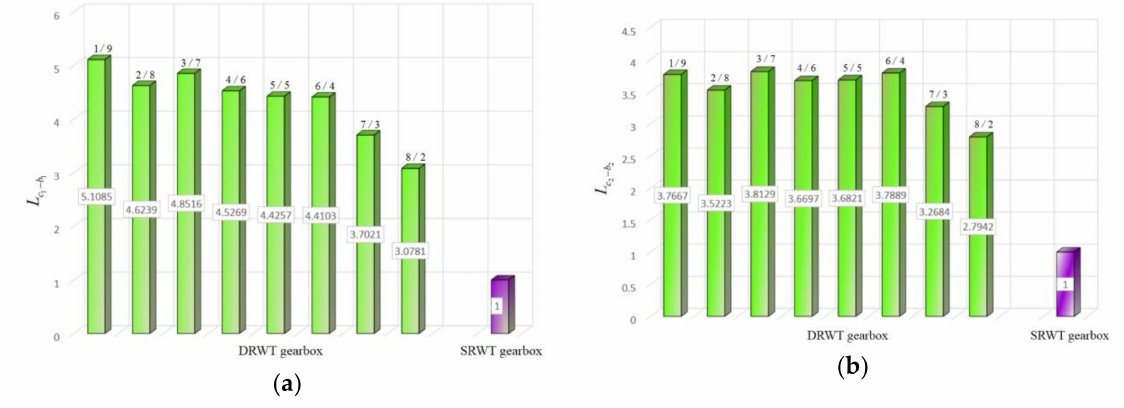
Figure 10. Bearing life of planet gear: ( a ) first planetary stage; ( b ) second planetary stage.